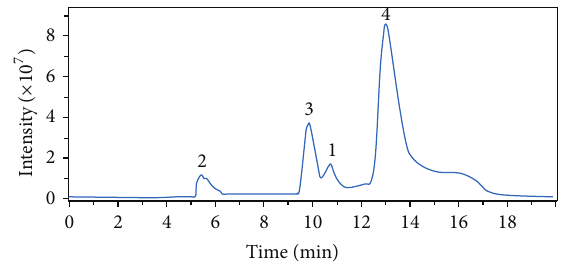
Figure 3: Mixture of standards. List of peaks with their retention times (1 = BisGMA: 10.6 min; 2 = TEGDMA: 5.3 min; 3 = UDMA: 10 min; 4 = new peak “reaction product”: ∼